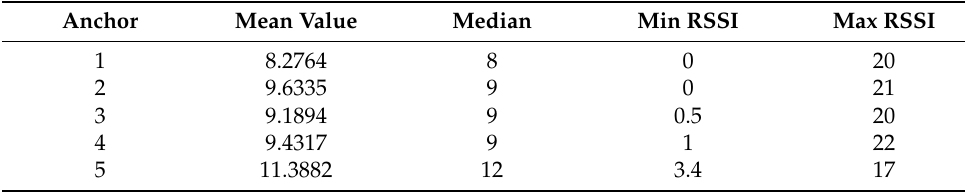
Table 1. Characteristic RSSI values in the case of industrial laboratory.